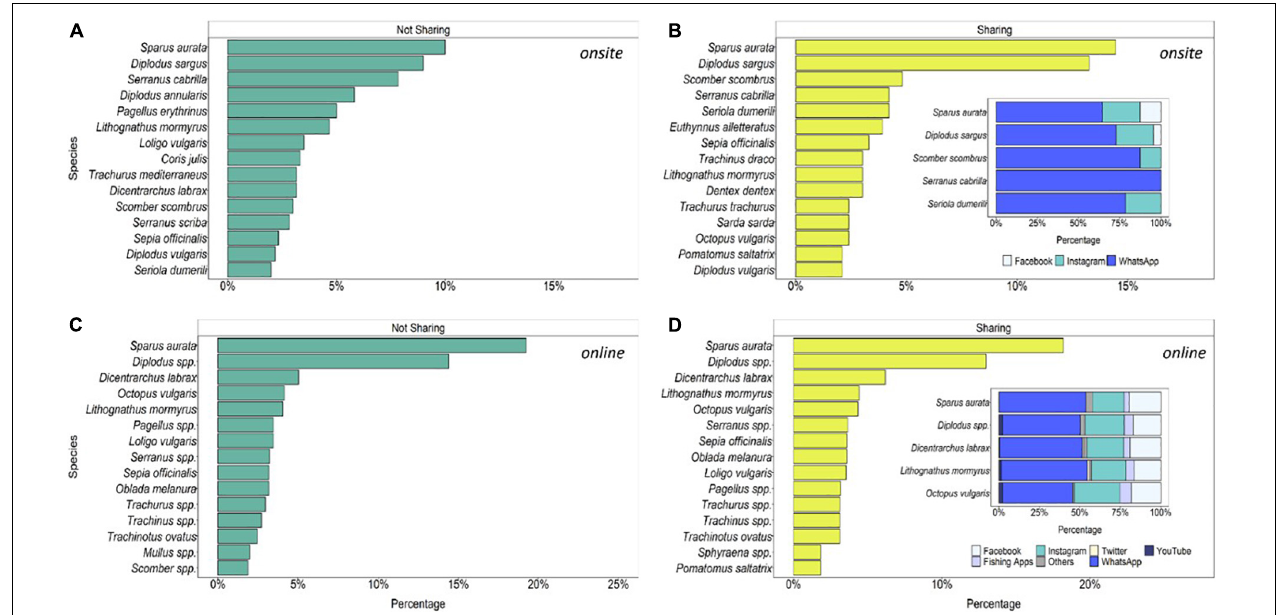
FIGURE 8 | Frequency distribution of the most caught species by recreational fishers during their last fishing trip, according to their sharing habits on digital platforms ( A,C for non-sharers, B,D for sharers), and according to the different digital platforms used to share (inlets of panels C,D ), for the onsite (A,B) , and the online surveys (C,D)